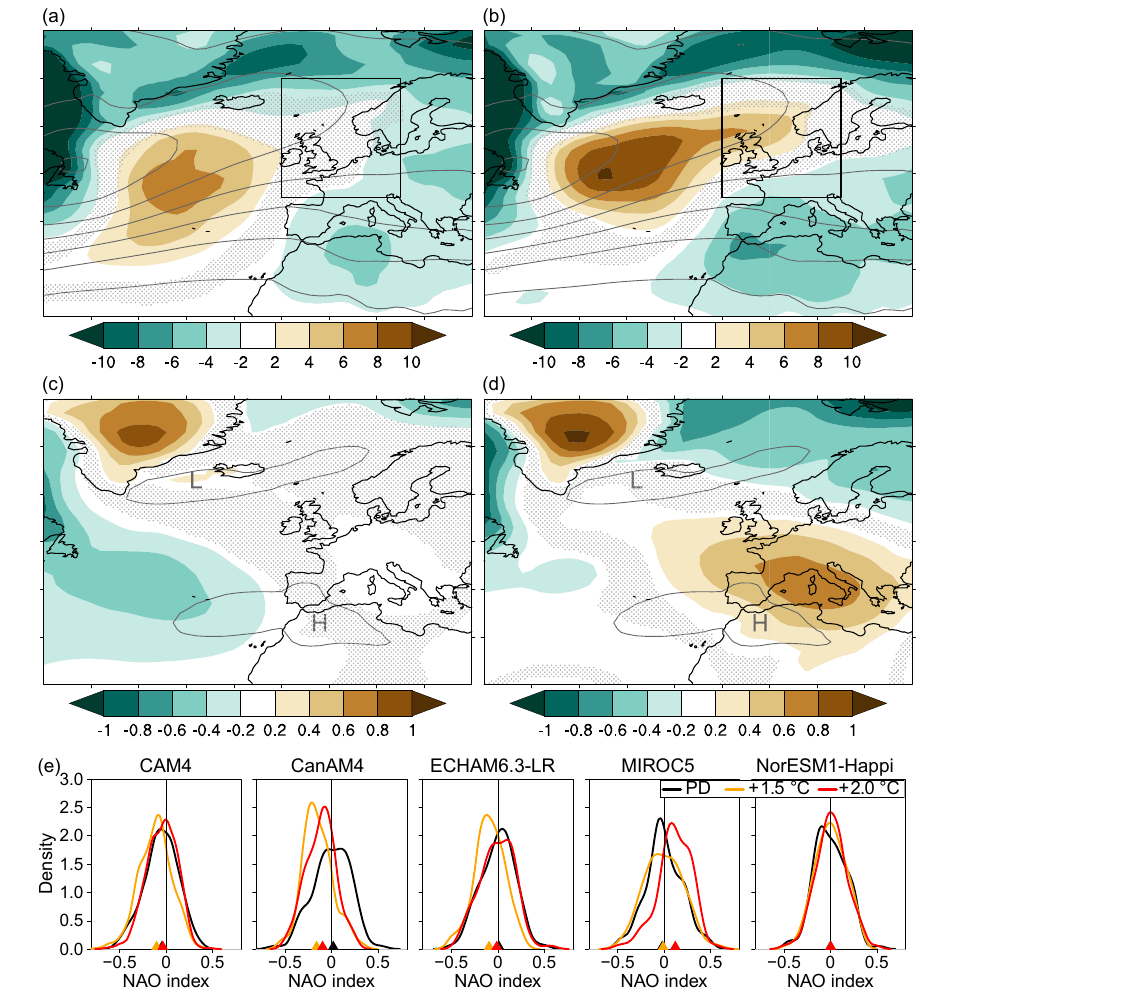
Figure 15. Multi-model mean response of winter (DJF) MSLP storm track and sea level pressure over the Euro-Atlantic sector in (a, c) 1.5 ◦ C and (b, d) 2.0 ◦ C relative to PD (shading, units:hPa) along with the PD climatology (contour interval 5hPa in a, b ; 1000 and 1025hPa contours in c, d ). Stippling in maps masks out regions where the response is very weak (signal-to-noise ratio | β/σ | < 0 . 1). (e) Distributions of the NAO index showing the spread and median (triangle) for each model and